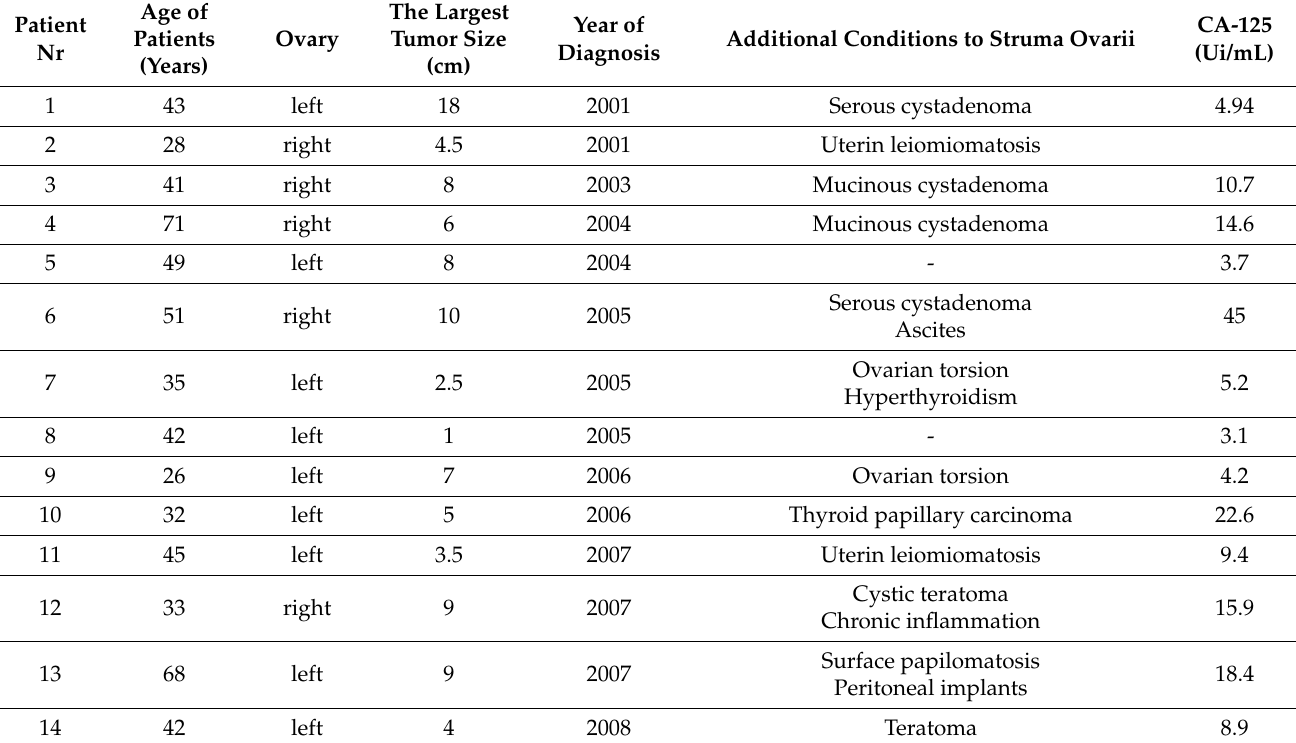
Table 1. Main epidemiological and clinico-morphological data of the study